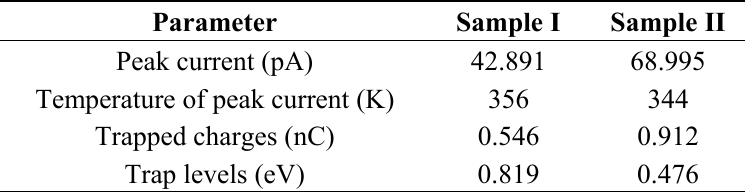
Table 5. Thermally stimulated current (TSC) test